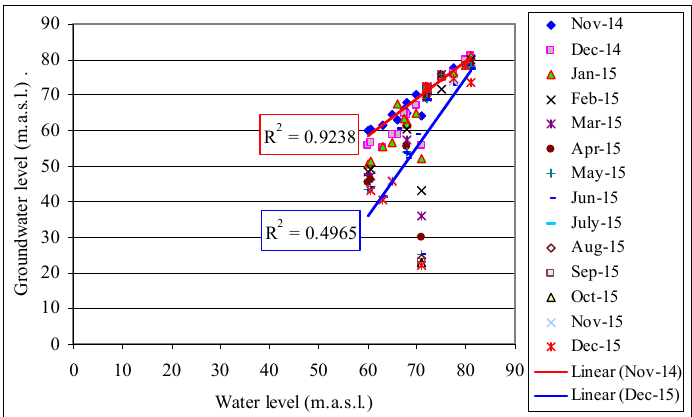
Figure 19. Coefficient of determination of parameters during the second period (October 2014–December 2015).